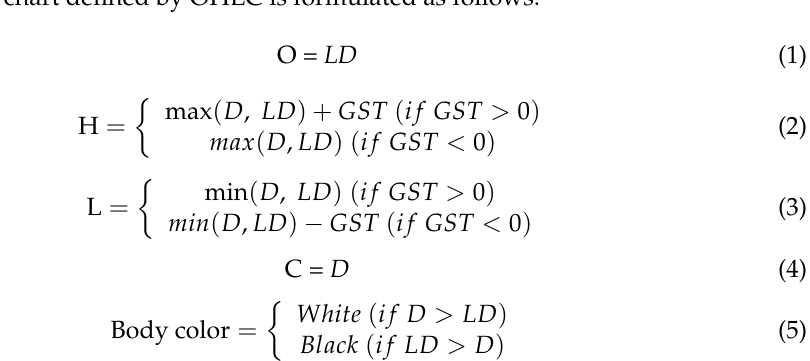
Figure 3. Candlestick chart of Cleveland in 2015/2016 and 2016/2017. As shown in Figures 2 and 3, the OHLC sports time series include positive and neg- ative values, which greatly differ from the traditional time series of stock prices, where all values are greater than 0. The OHLC sports time series reflect the gap between two teams in the match. These time series are equivalent to the stationary return time series of the stock prices, which are derived by differencing its original non-stationary price time se- ries. Stationary time series forms are beneficial for time series prediction modeling. How- ever, the existence of meaningful patterns in sports candlesticks, such some identified pat- terns (e.g., morning star, bullish engulfing, etc.), warrants further investigation.